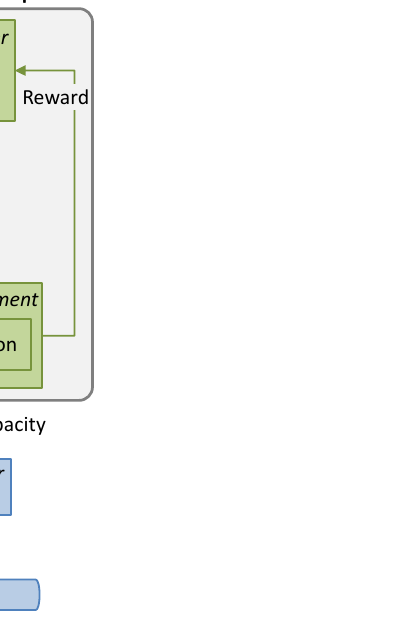
Figure 1. Flow capacity autonomous operation. RL framework with learner, agent, and environ- ment.